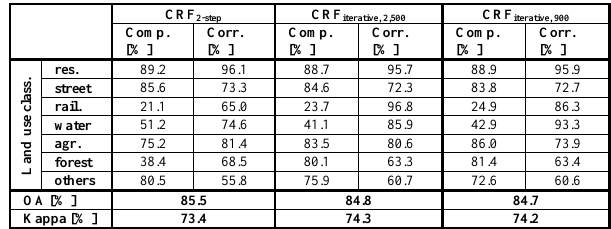
Table 2. Overall accuracy [%], kappa index [%], completeness (comp.) and correctness (corr.) values [%] for the land use classes res. , street , rail. , water , agr. , forest and others